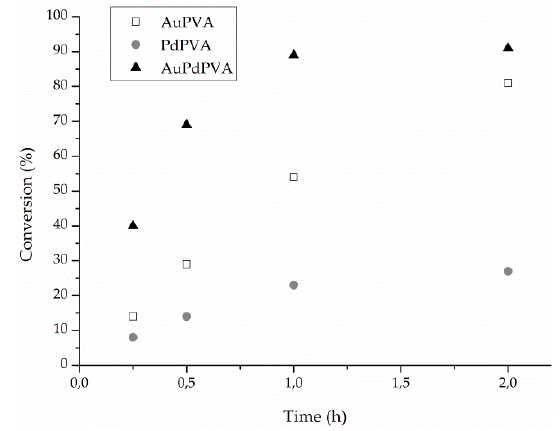
Figure 2. Reaction profiles for Au PVA , Pd PVA and AuPd PVA nanoparticles.